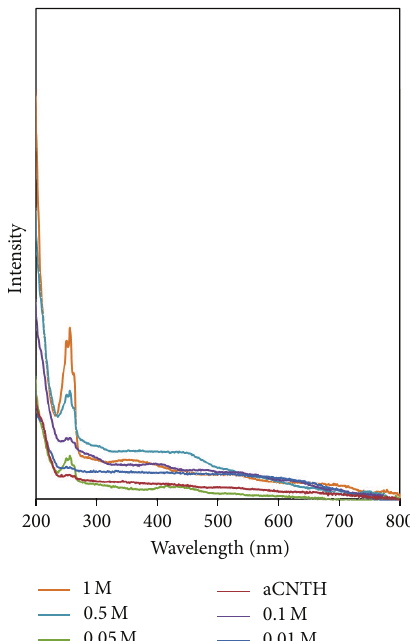
Figure 9: Absorption spectra of HCl functionalized 𝛼 CNTH/Ag nanohybrids at different molars of AgNO 3 .